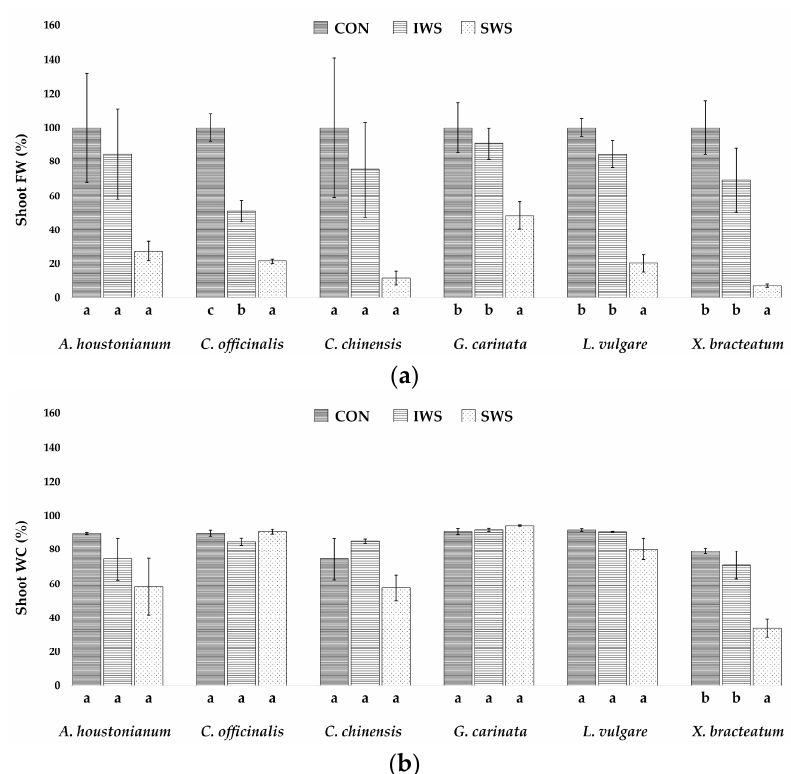
Figure 4. Effect of water stress on the shoot fresh weight (FW) ( a ) and water content (WC) ( b ) in the six Asteraceae species. Bars indicate mean values with SE ( n = 5) of percentage relative to the control averages for each species, shown in Table 1. Different lowercase letters indicate significant differences between treatments (CON—control, IWS—intermediate water stress, and SWS—severe water stress) per species, according to the Tukey test ( p <